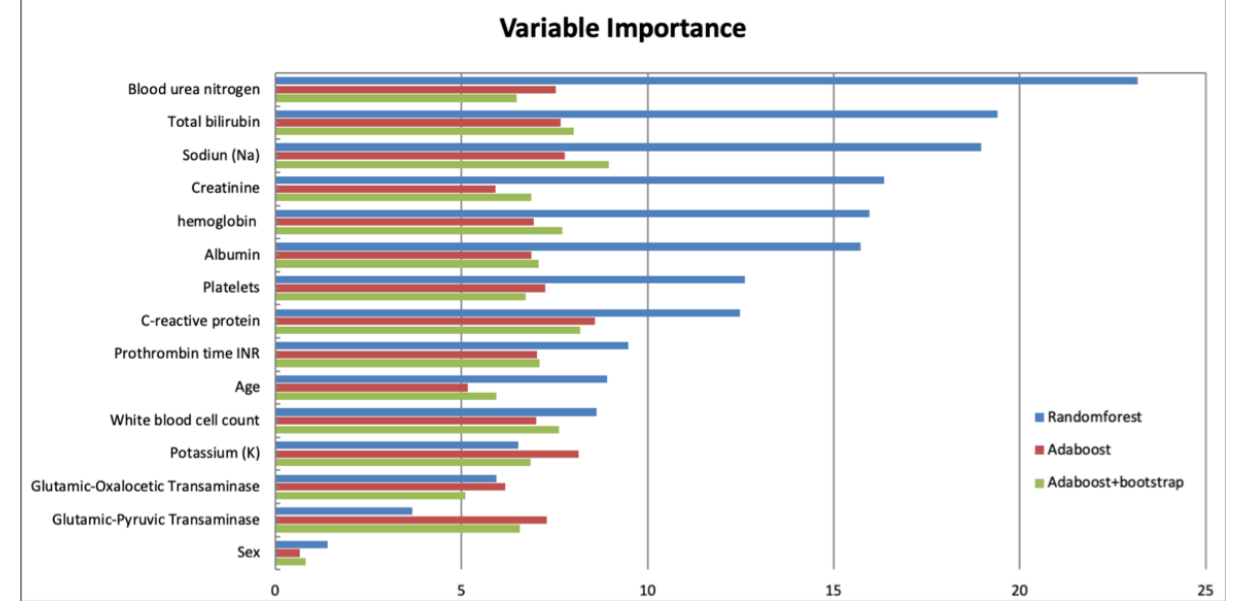
Figure 3. Variable importance ordered by the accuracy of mean decrease in random forest, adaptive boosting (AdaBoost), and AdaBoost + bootstrap. The order of variables is followed by the rank of leading variables in the random